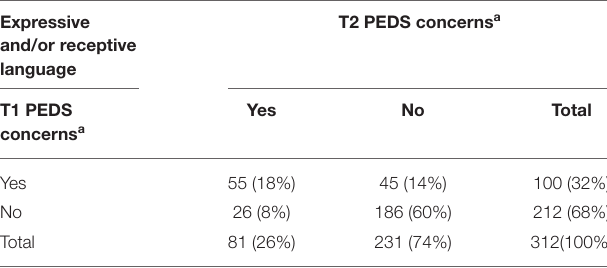
TABLE 3 | Stability of PEDS concerns about language development at the age of 3 and 4 years.